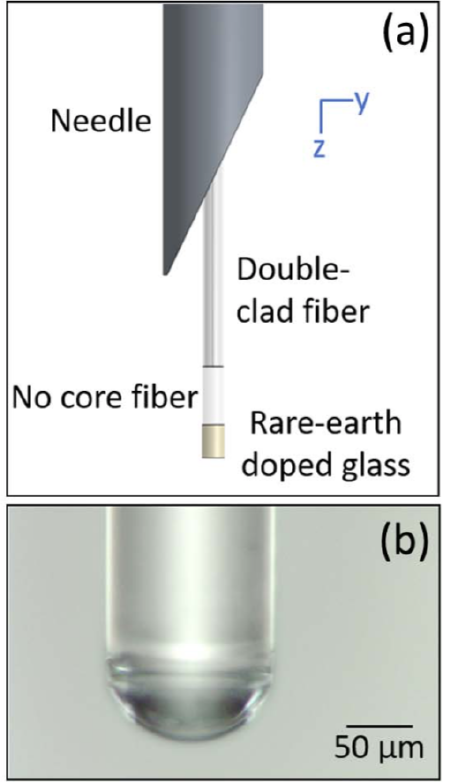
Figure 3. Needle probe for temperature sensing. Top ( a ): a DCF-based catheter coming out of a needle. Bottom ( b ): microscopic image of the probe tip with a curved focusing element. Images reprinted with permissions from ref. [44]. Copyright 2018